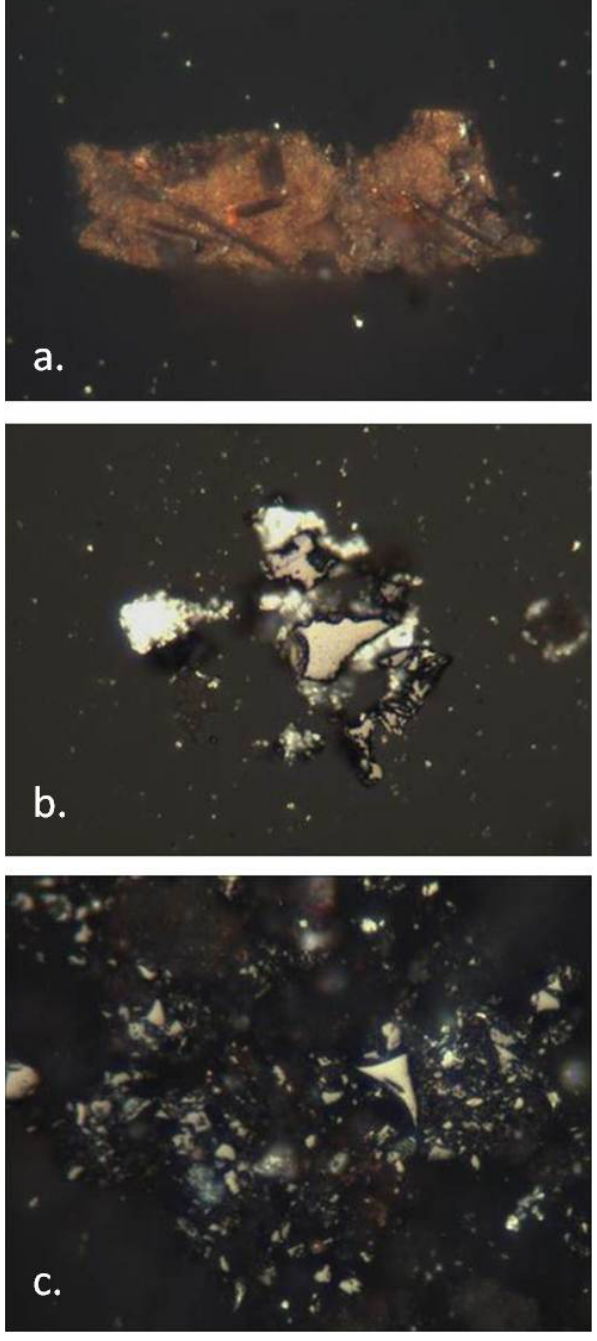
Fig. 2. Photomicrographs of LZ1029-7 of magnetic separates. (a) Volcanic rock fragment measuring approximately 80µm in longest dimension. (b) Partially dissolved titanomagnetite with precipitated titanium dioxide (bright white versus dull white) about 74µm along longest dimension. (c) Small, angular magnetite grains. Bright white triangular magnetite grain measures approximately 14µm along long